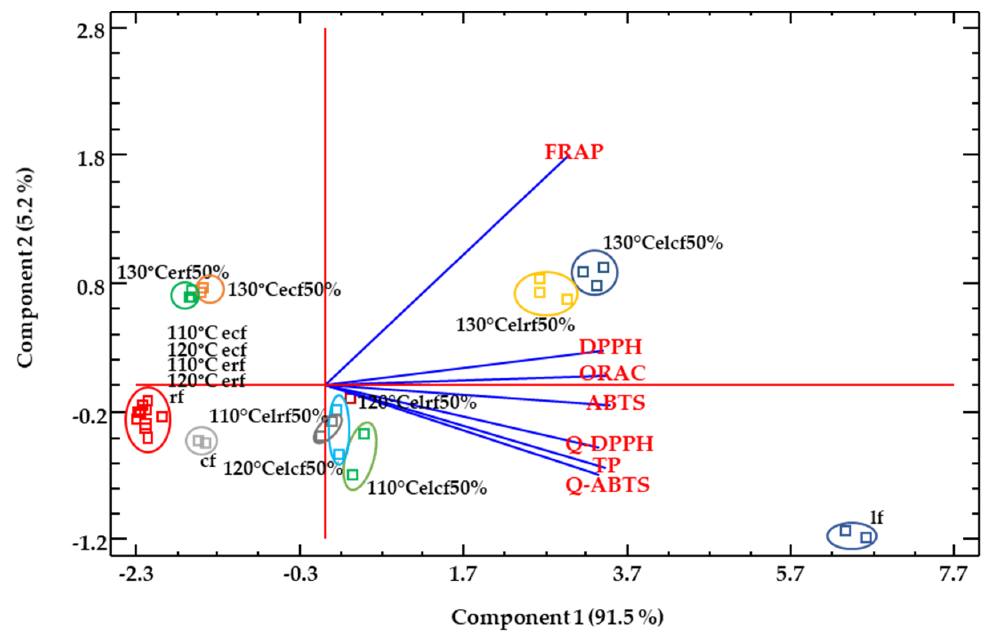
Figure 3. PCA analysis for native flours and extruded flours at different conditions. Abbreviations: cf: corn flour; rf: rice flour; lf: lentil flour; ecf: extruded corn flour; erf: extruded rice flour; elcf: extruded lentil (50%)-corn flour; elrf: extruded lentil (50%)-rice flour.